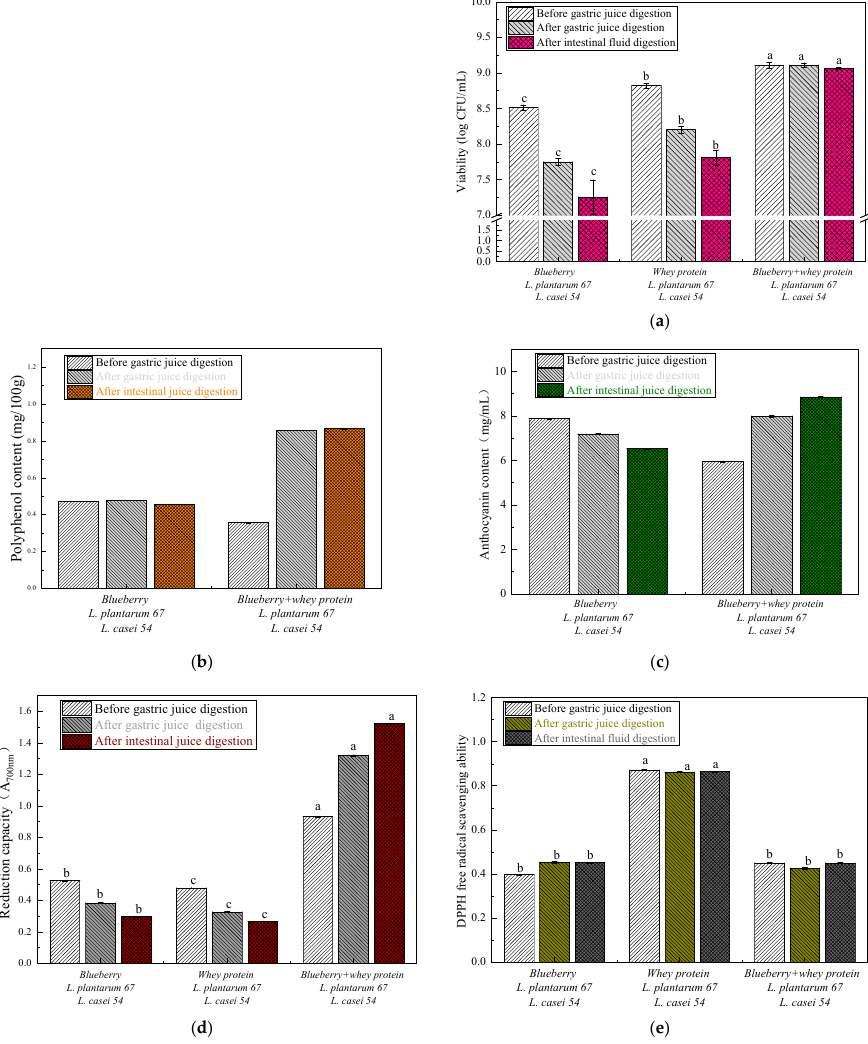
Figure 3. The total colony count ( a ), total phenol content ( b ), total anthocyanin content ( c ), reduction capacity ( d ) and DPPH-radical-scavenging activity ( e ) of the fermentation system with L. plantarum 67 and L. casei 54 before and after in vitro gastrointestinal digestion. Di ff erent le tt ers within the same column indicate signi fi cant di ff erences ( p < 0.05).